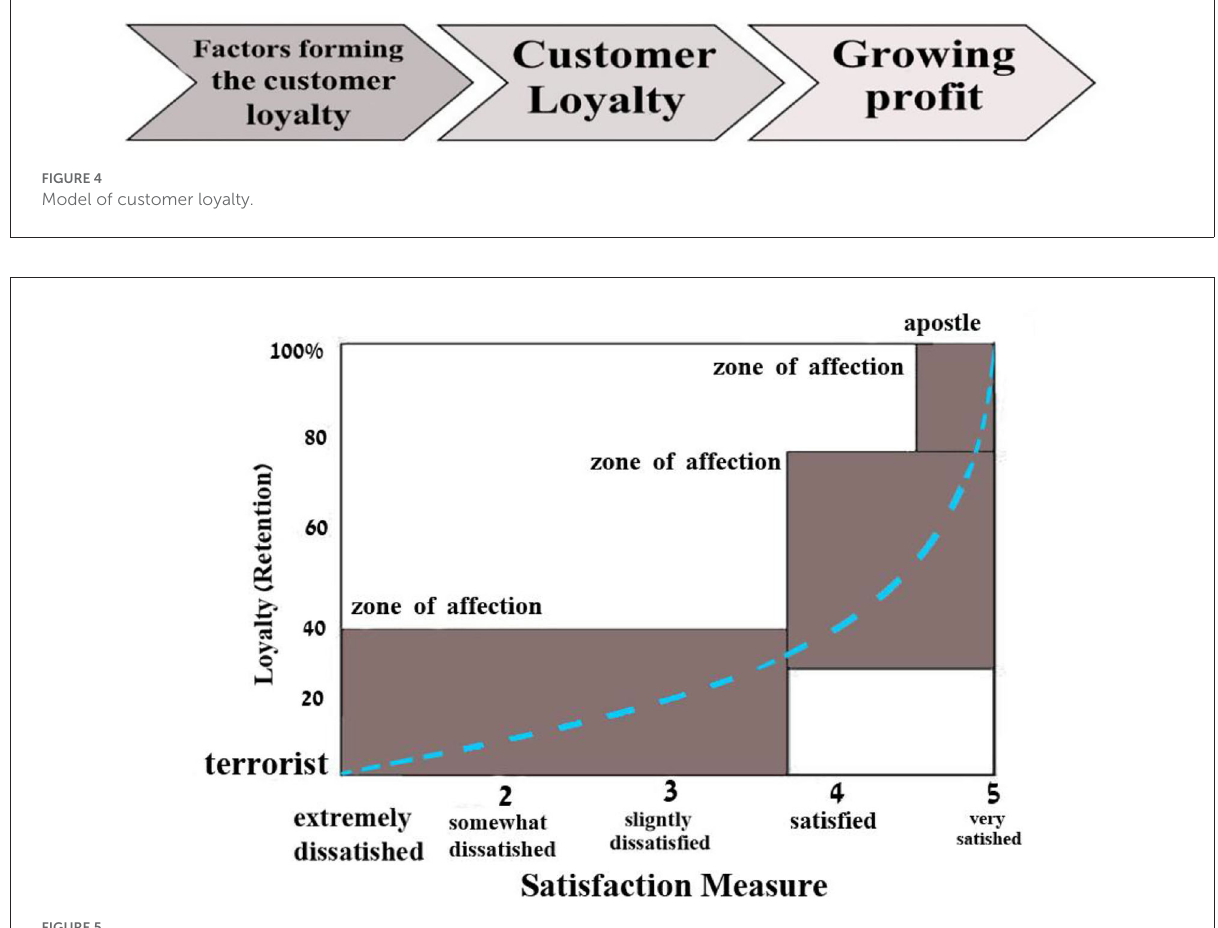
FIGURE5 Client satisfaction and loyalty are